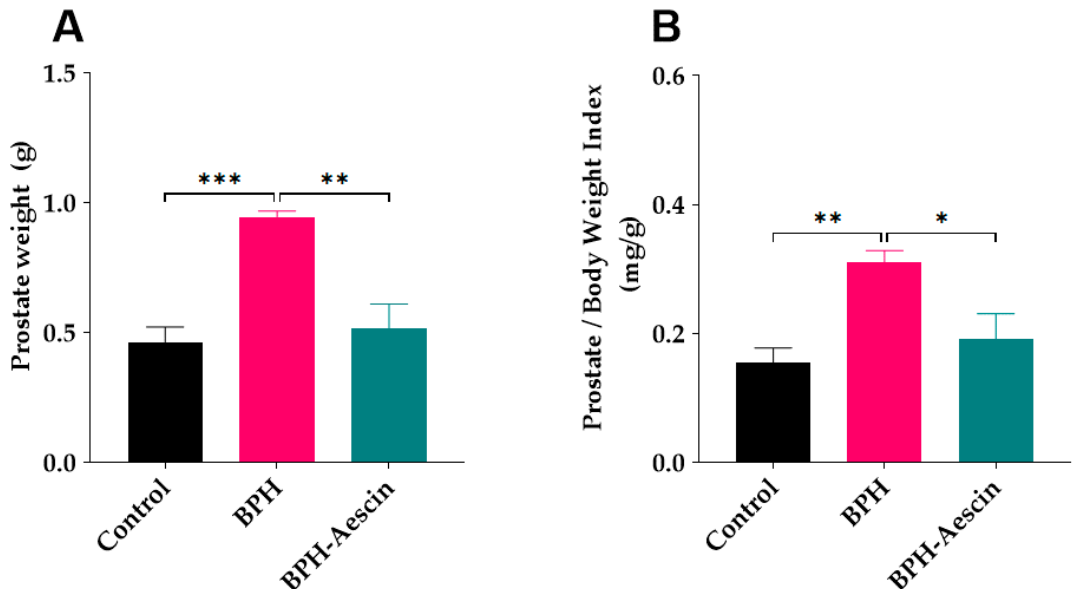
Figure 1. Aescin prevents testosterone-induced prostatic hyperplasia. The prostate glands were harvested from euthanized rats, dissected from surrounding tissues, and immediately weighed (g) on a sensitive balance ( A ). The prostate weight/body weight index (mg/g) was calculated as a ratio for each animal ( B ). Rats in control, BPH, and BPH–aescin groups received sesame oil (s.c.), testosterone (3 mg/kg, s.c.) dissolved in sesame oil, and testosterone (3 mg/kg, s.c.) dissolved in sesame oil + aescin (10 mg/kg, p.o.), respectively, for 4 weeks. Data (Mean ± SEM, n = 5) were analyzed by one-way analysis of variance (ANOVA) followed by Tukey’s multiple comparisons test. *, **, and *** denote significant differences between the selected study groups at p < 0.05, 0.01, and 0.001, respec- tively.